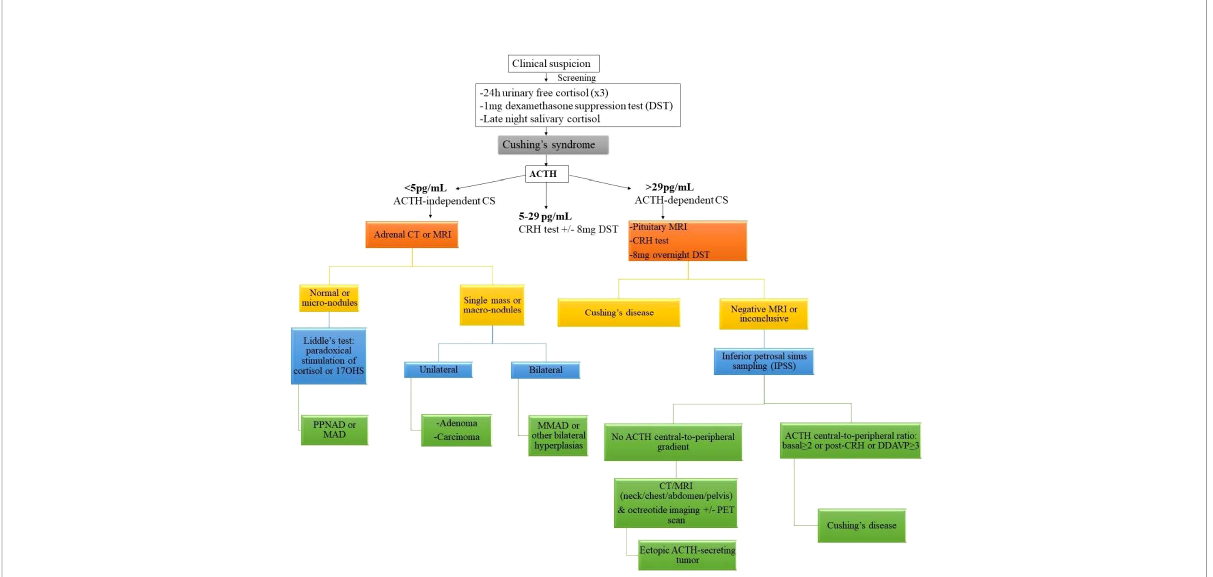
FIGURE 1 Diagnostic algorithm for suspected Cushing syndrome. ACTH adrenocorticotropic hormone, CS Cushing syndrome, CT computed tomography, DDAVP desmopressin, MAD micronodular adrenal disease, MRI magnetic resonance imaging, PET positron emission tomography, 17OHS 17- hydroxysteroid. Reprinted from Constantine A. Stratakis. Cushing Syndrome in Pediatrics. Endocrinology and Metabolism Clinics of North America. Volume 41, Issue 4, December 2012, Pages 793-803, with permission from